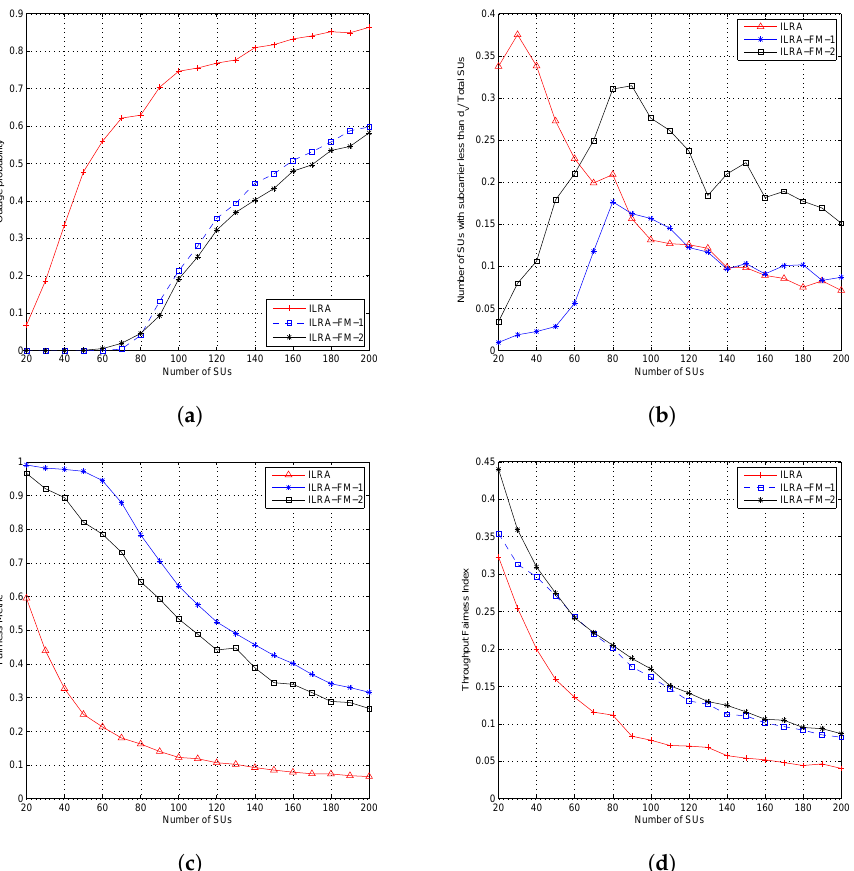
Figure 5. Performance of the proposed algorithm at d c = 6 and d v = 8, ( a ) outage probability, ( b ) number of SUs that obtain less than d v subcarriers, ( c ) fairness metric, and ( d ) throughput fairness Index.